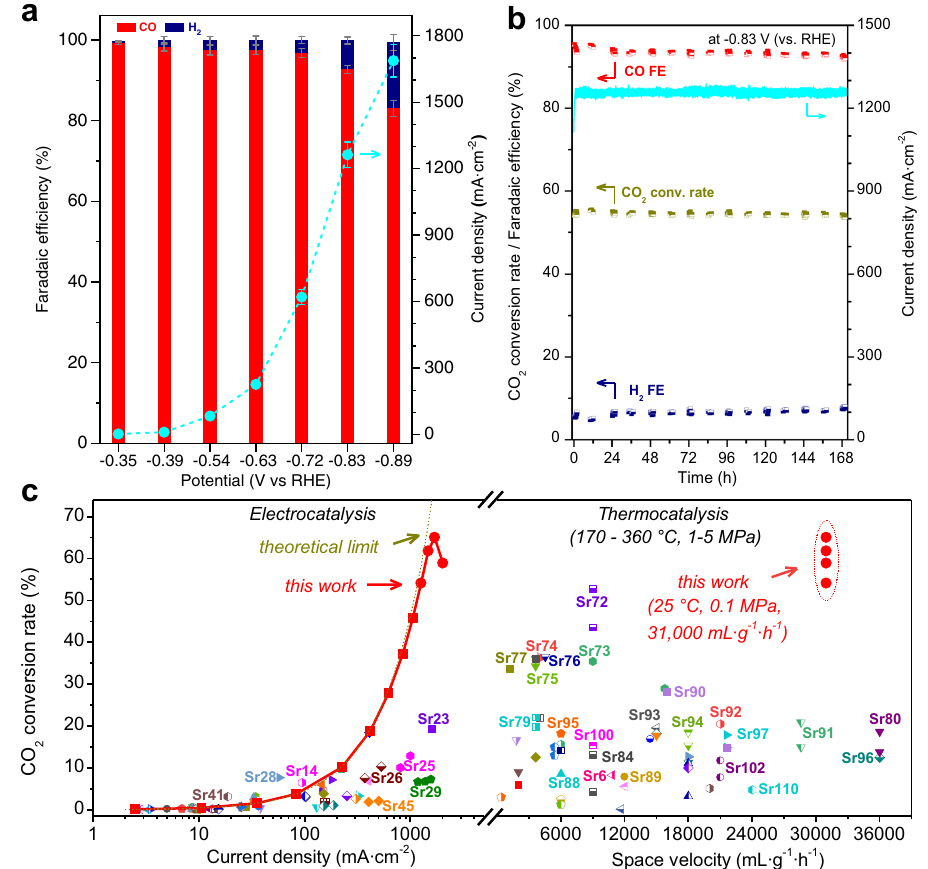
Fig. 3 Performance of activated Ag HF. a CO and H 2 faradaic ef fi ciencies, and total current densities in the potential range of − 0.35 to − 0.89 V. Error bars in a were obtained from the average of six individual tests. b Long-term performance at − 0.83 V. c CO 2 conversion rates with a space velocity of 31,000 mL·g cat − 1 · h − 1 at different current densities, and their overall comparison with other electrocatalytic and thermocatalytic CO 2 conversions. All comparison data points in c are from the references summarized in Supplementary Table S1, and the key data points are referred to the corresponding Supplementary references Srx, where x represents the reference number in Supplementary Information. CO 2 -saturated 1.5 M KHCO 3 as the electrolyte solution, and the CO 2 fl ow rate of 60 mL · min − 1 .